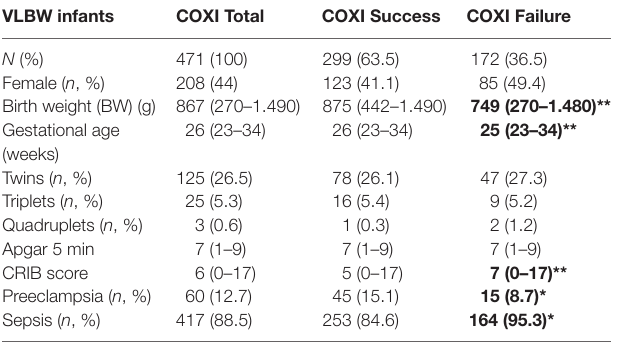
TaBle 1 | Characteristics of VLBW infants undergoing pharmacological treatment by cyclooxygenase inhibitors (COXI) for hemodynamically significant patent ductus